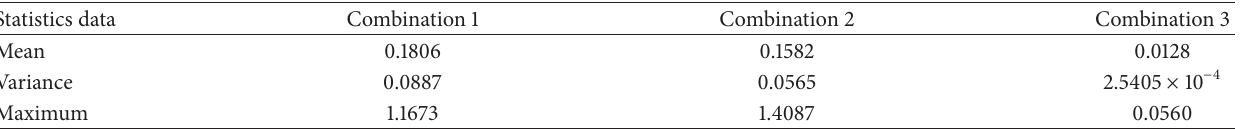
Table 7: Statistics of asynchronous mutual correlation values of 3 combination